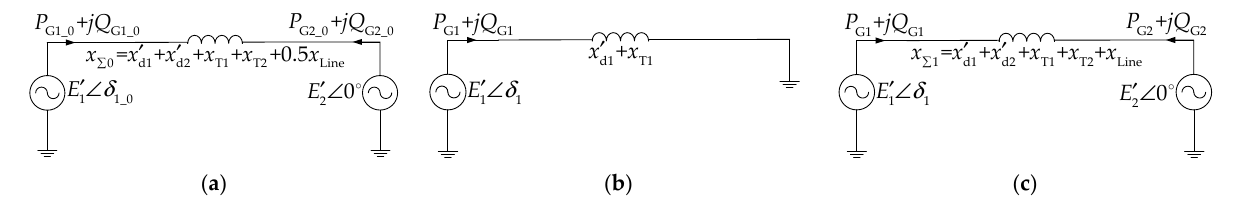
Figure A1. The circuit diagram of the two-area interconnected system. ( a ) Circuit before the fault occurs. ( b ) Circuit of Region 1 during the fault. ( c ) Circuit after the fault is clear. The circuit diagram of the two-area system before the fault occurs is shown in Figure A1a. In this case, we have